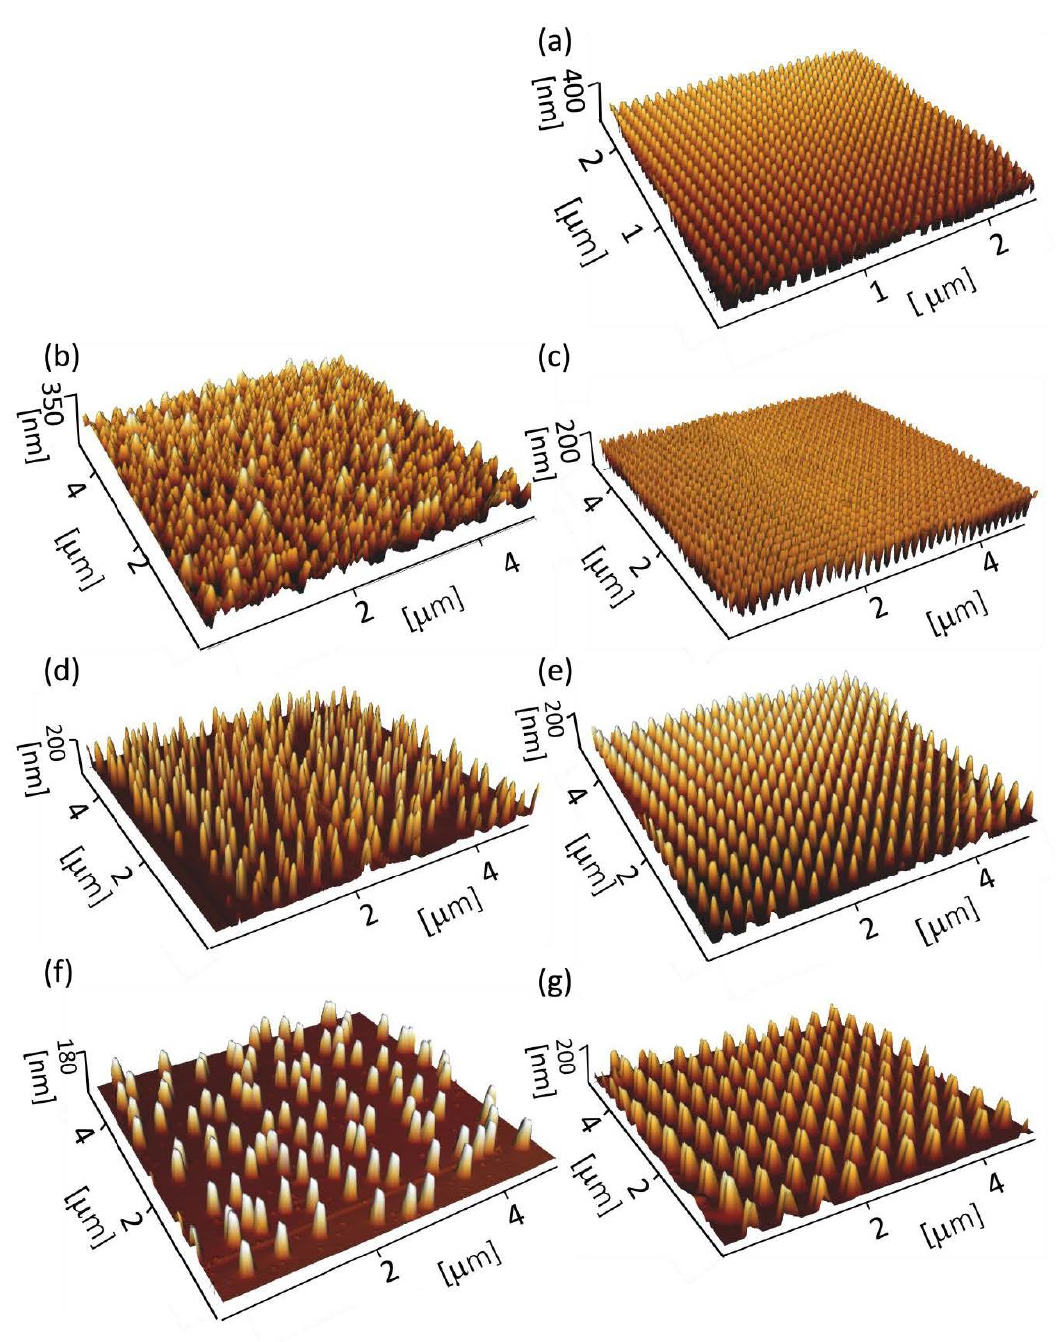
Figure 2. 3D AFM images of ( a ) 100 O ; ( b ) 170 D ; ( c ) 170 O ; ( d ) 300 D ; ( e ) 300 O ; ( f ) 500 D ; ( g ) 500 O nanopillars.